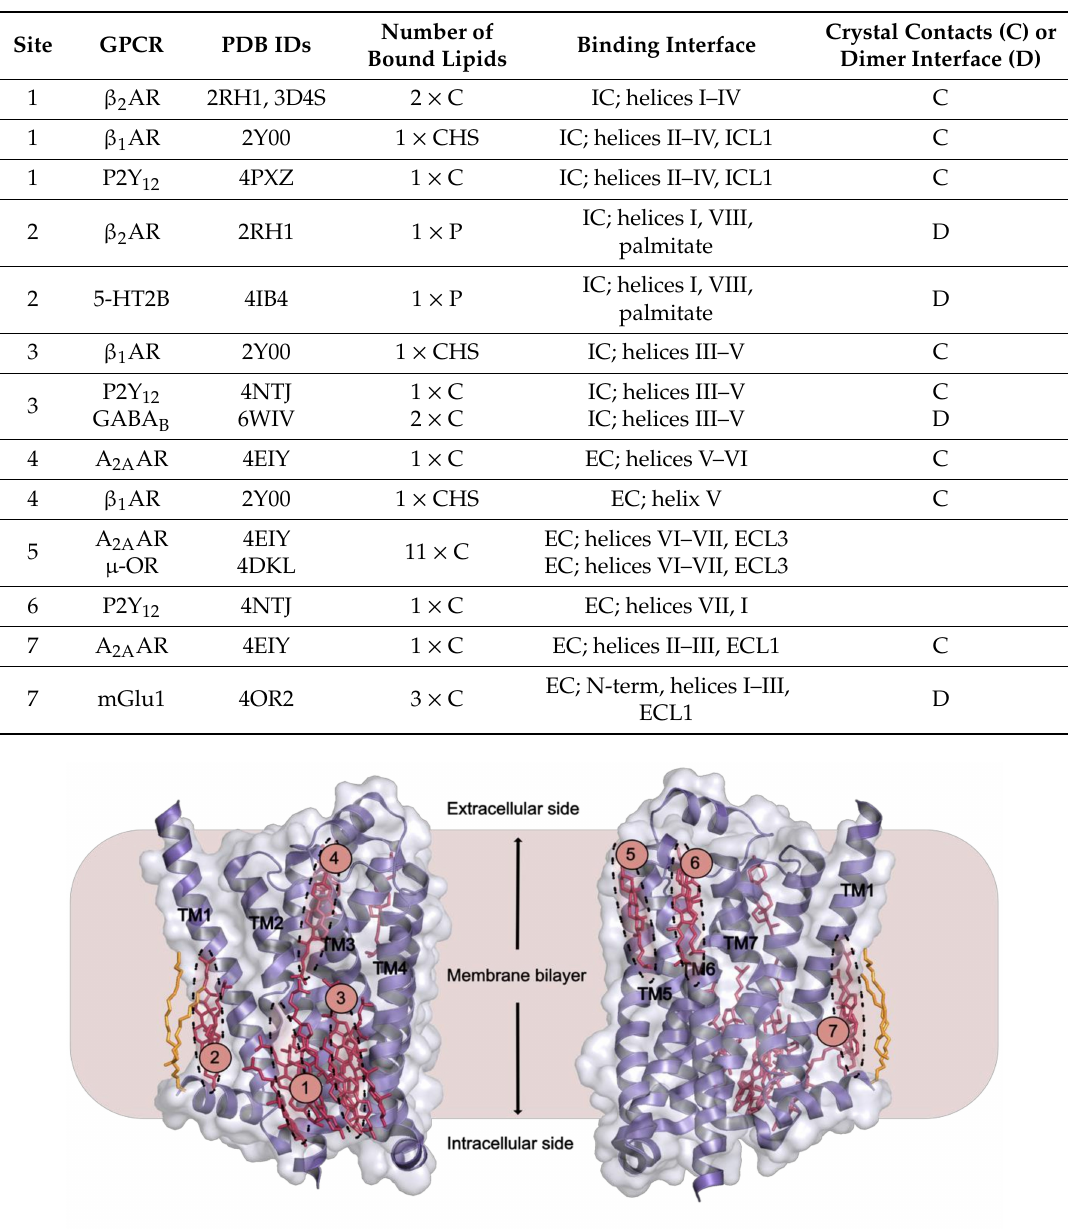
Table 1. Lipid binding sites in GPCR crystal structures for cholesterol (C), cholesteryl hemisuccinate (CHS) and palmitate (P). The number of bound lipids and the binding interfaces are indicated (IC, intracellular cleft; EC, extracellular cleft; ECL, extracellular loop; ICL, intracellular loop). The locations of the individual binding sites 1–7 are shown in Figure 3.